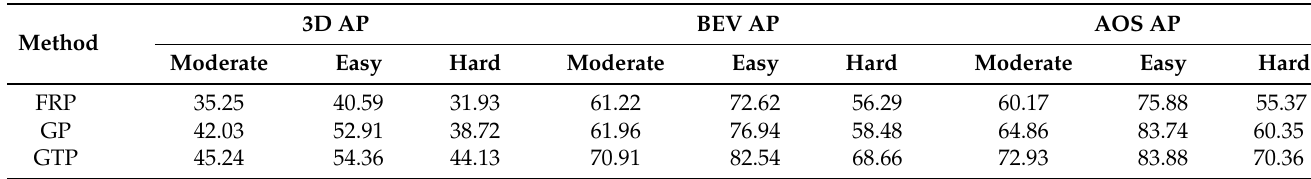
Table 4. Comparison of different placing algorithms.